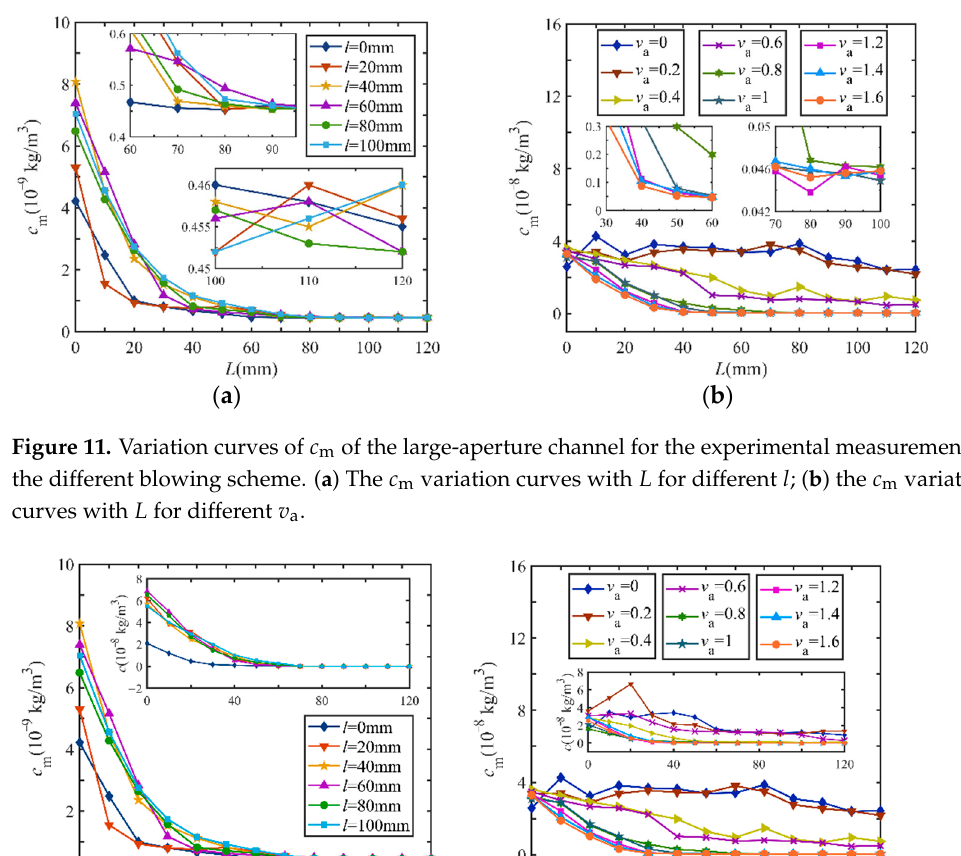
Figure 12. Comparison curves between experimental and simulation data. ( a ) The c m and c variation curves with L for different l ; ( b ) The c m and c variation curves with L for different v a